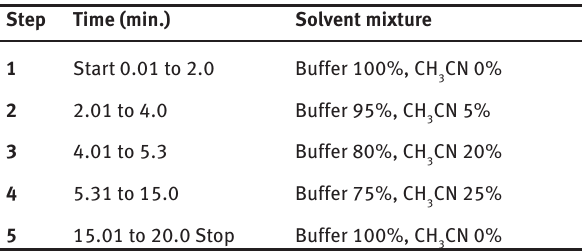
Table 2: Program employed for HPLC pumps for separating ADP and ATP Step Time (min.) Solvent